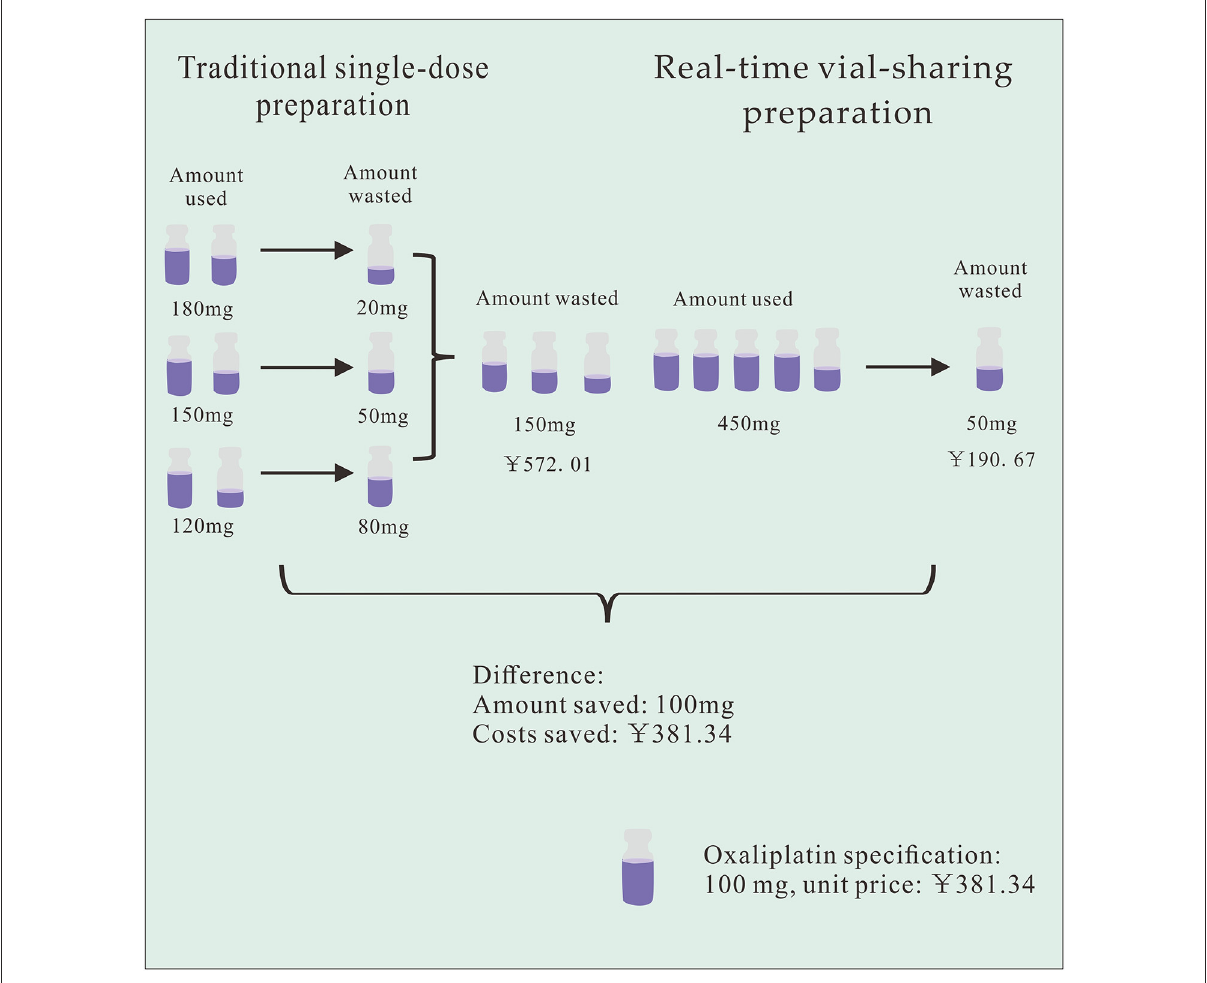
FIGURE1 Example of cost-saving diagrams with Oxaliplatin at one time interval.